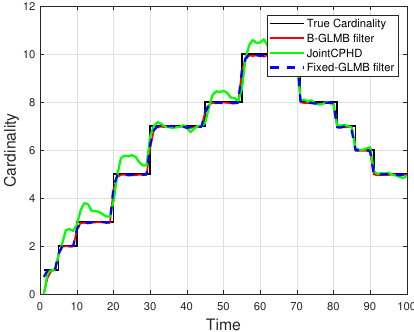
Figure 5. Cardinality tracking